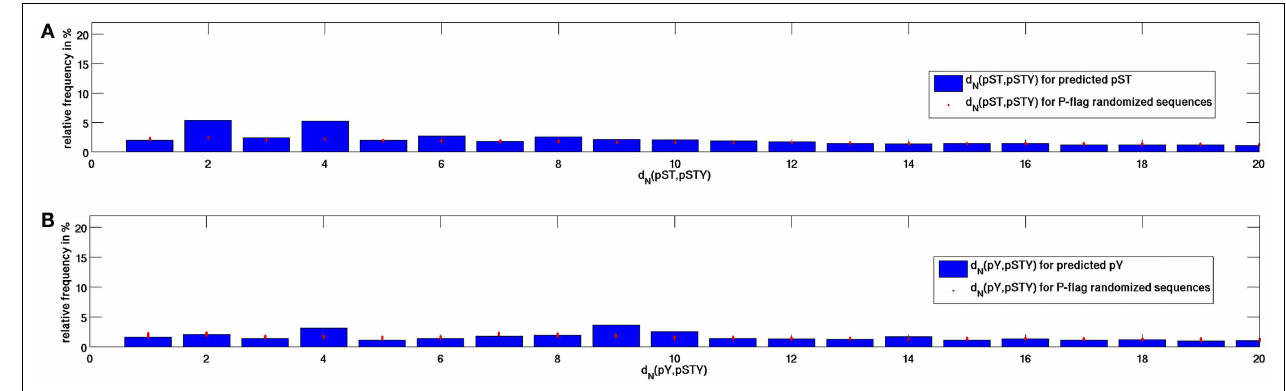
circles. Evidently, the nearest neighbor distance distribution differs from the distribution between experimentally identified sites ( Figure 1 ) with a secondary peak at d N (pST, pSTY) = 4 and a more even distribution of d N (pY, pSTY) for predicted